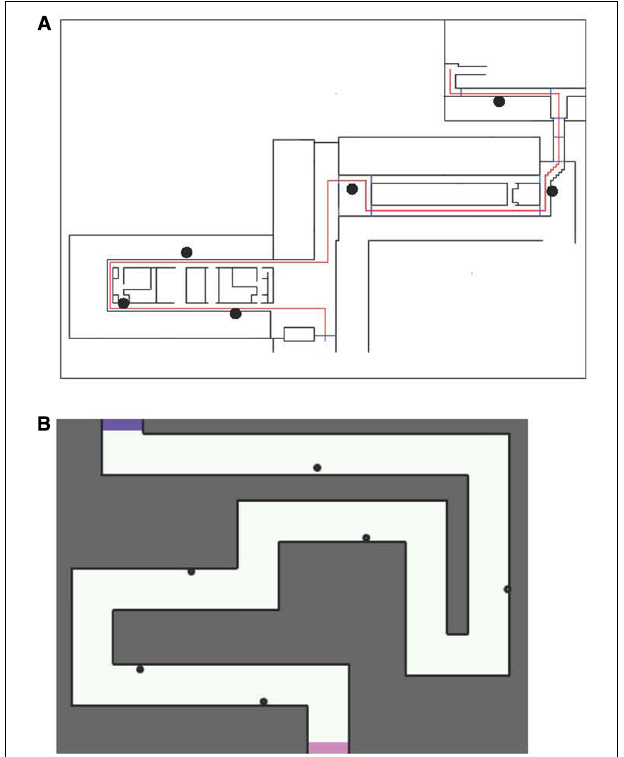
FIGURE 1 | Map of the routes used on the (A) real and (B) hybrid and virtual conditions. In both maps, participants moved from the bottom to the top of the map. Dots indicate landmark